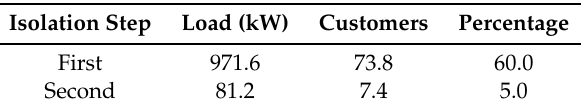
Table 4. Average losses after a short circuit in SS8.